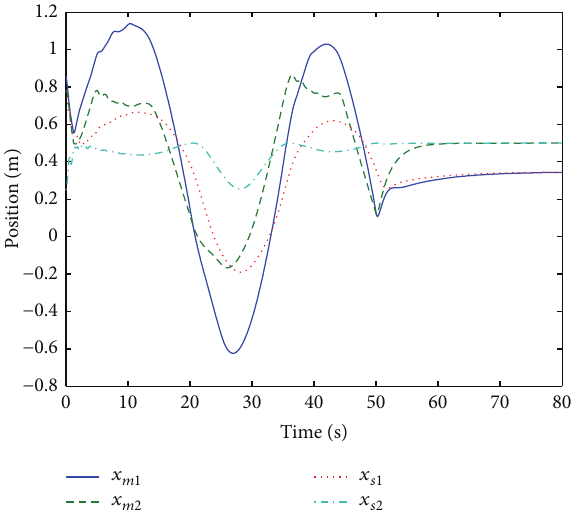
Figure 6: The positions of the master and the slave in task space with the known gravity